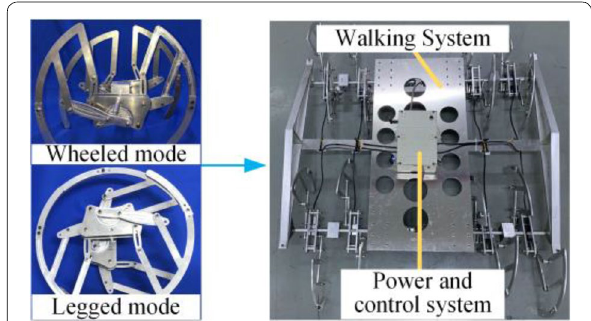
Figure 16 Experimental system